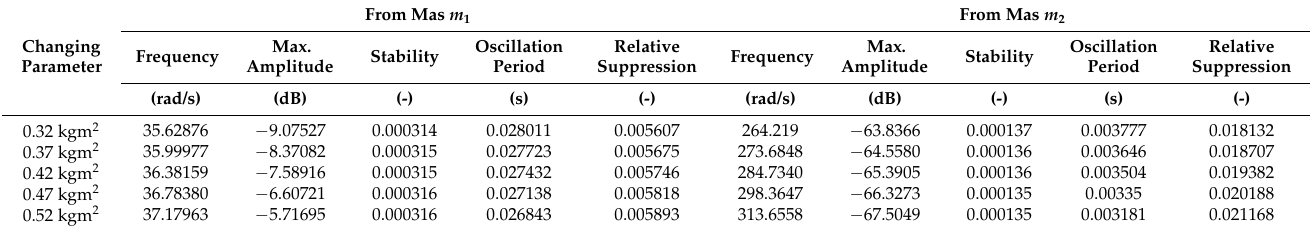
Table 3. The values of the parameters read from the graphs shown in Figure 9.